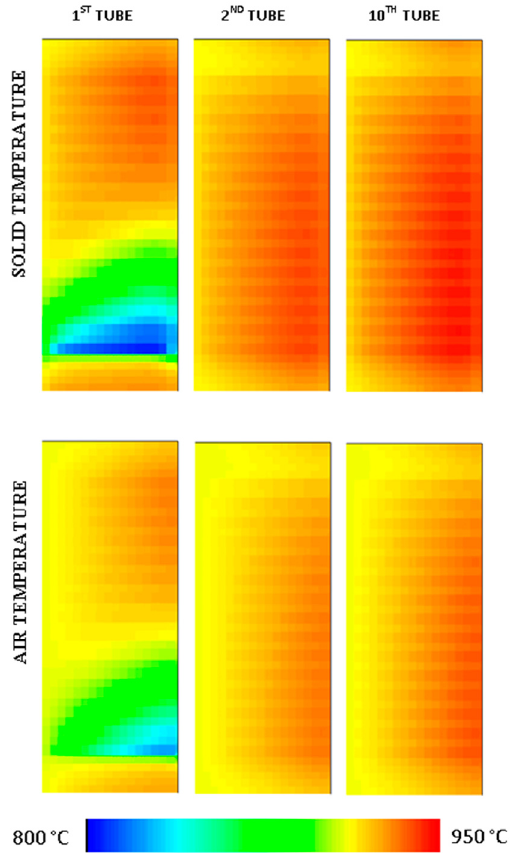
Figure 7. 2D temperature distribution of the solid structure and of the air (for the first, second and 10 th tube of the bundle).